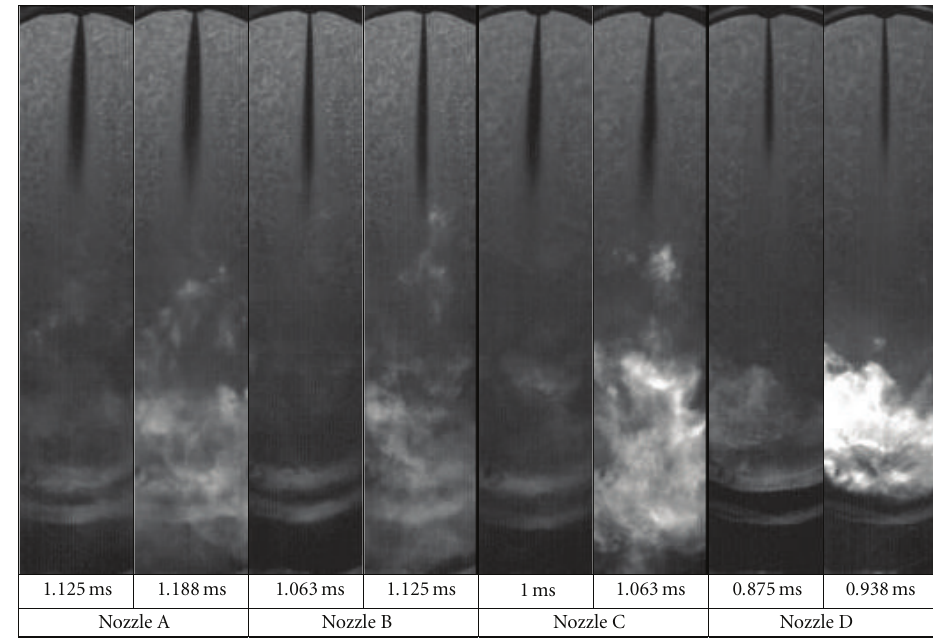
Figure 21: The autoignition images of di ff erent nozzle types.